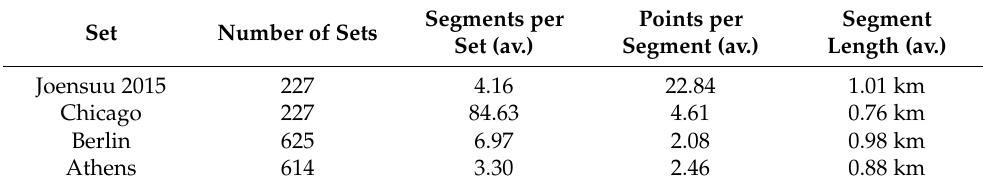
Table 2. Summary of the data used in the experiments. The data were divided into two parts: 100 sets for training (10%) and 901 sets for testing (90%). In total, there are k = 10,480 trajectories with N = 90,231 points. The training data were publicly available in the segment-averaging competition [7], while the testing data were published only afterwards. They are both available here: http://cs.uef.fi/ sipu/segments (accessed on 24 November